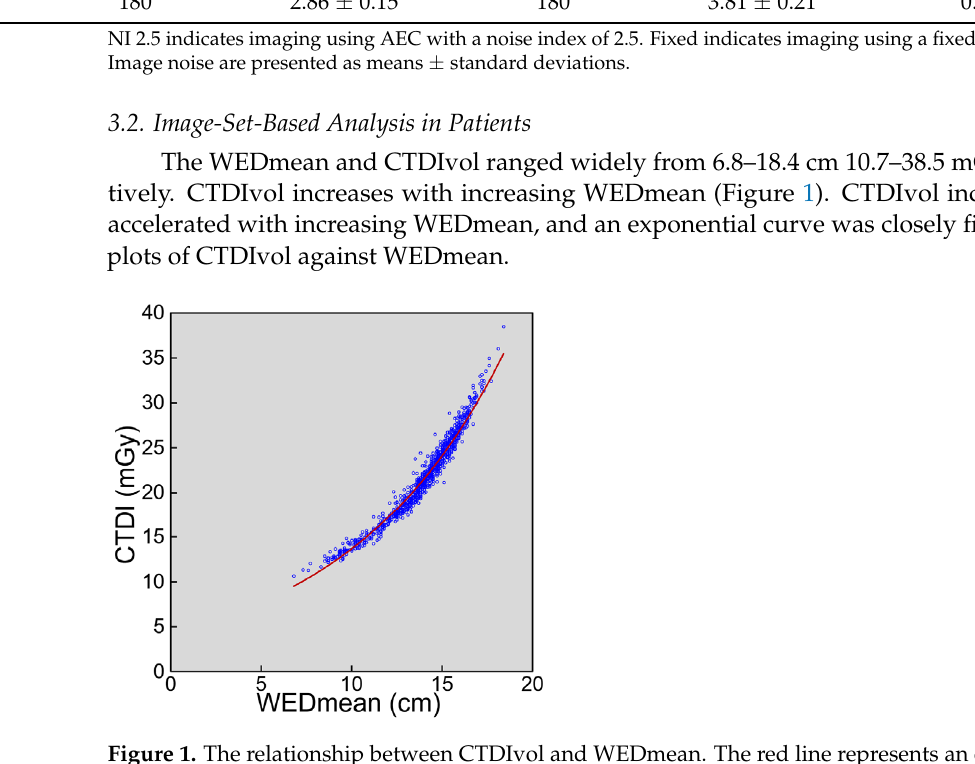
Figure 1. The relationship between CTDIvol and WEDmean. The red line represents an exponential regression curve (y = 4.396e 0.1135x , R 2 = 0.968).